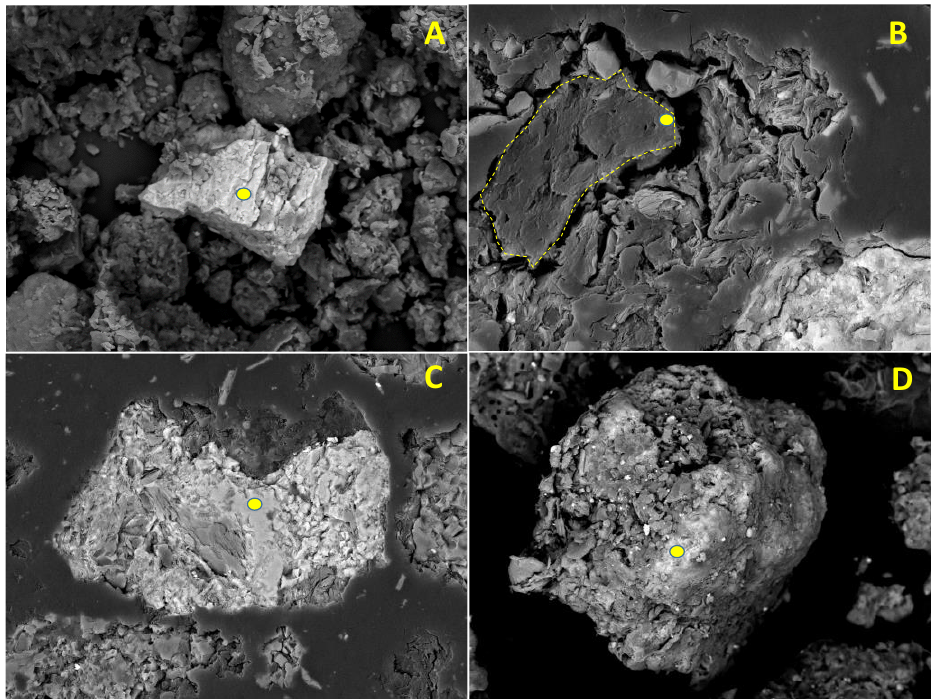
Figure 5. Different types of soil particles examined by means of backscattered electron (BSE-SEM) detection. Yellow points indicate areas of microanalysis. ( A ) Sb ochre (horizontal width: 100 μm, 64.65% Sb, 27.72% O, minor contents of Ca, Si and Al); ( B ) Organic matter (grain marked with yellow dashed line, horizontal width: 75 μm; 66.69% C, 20.18% O, 6.24% Si, 4.13% Al, 2.13% K, Mg, Ca and Fe below 1%); ( C ) Fe oxide (horizontal width: 150 μm, 54.49% Fe, 43.95% O, 1.34% Sb, 0.22% As); ( D ) Fe- Mn oxide (horizontal width: 110 μm, 40.70% O, 24.25% Fe, 12.06% Mn, 7.72% Si, 5.90% Al, 5.76%, Pb, 1.27% K, 1.00% Sb, Ca and As below 1%).